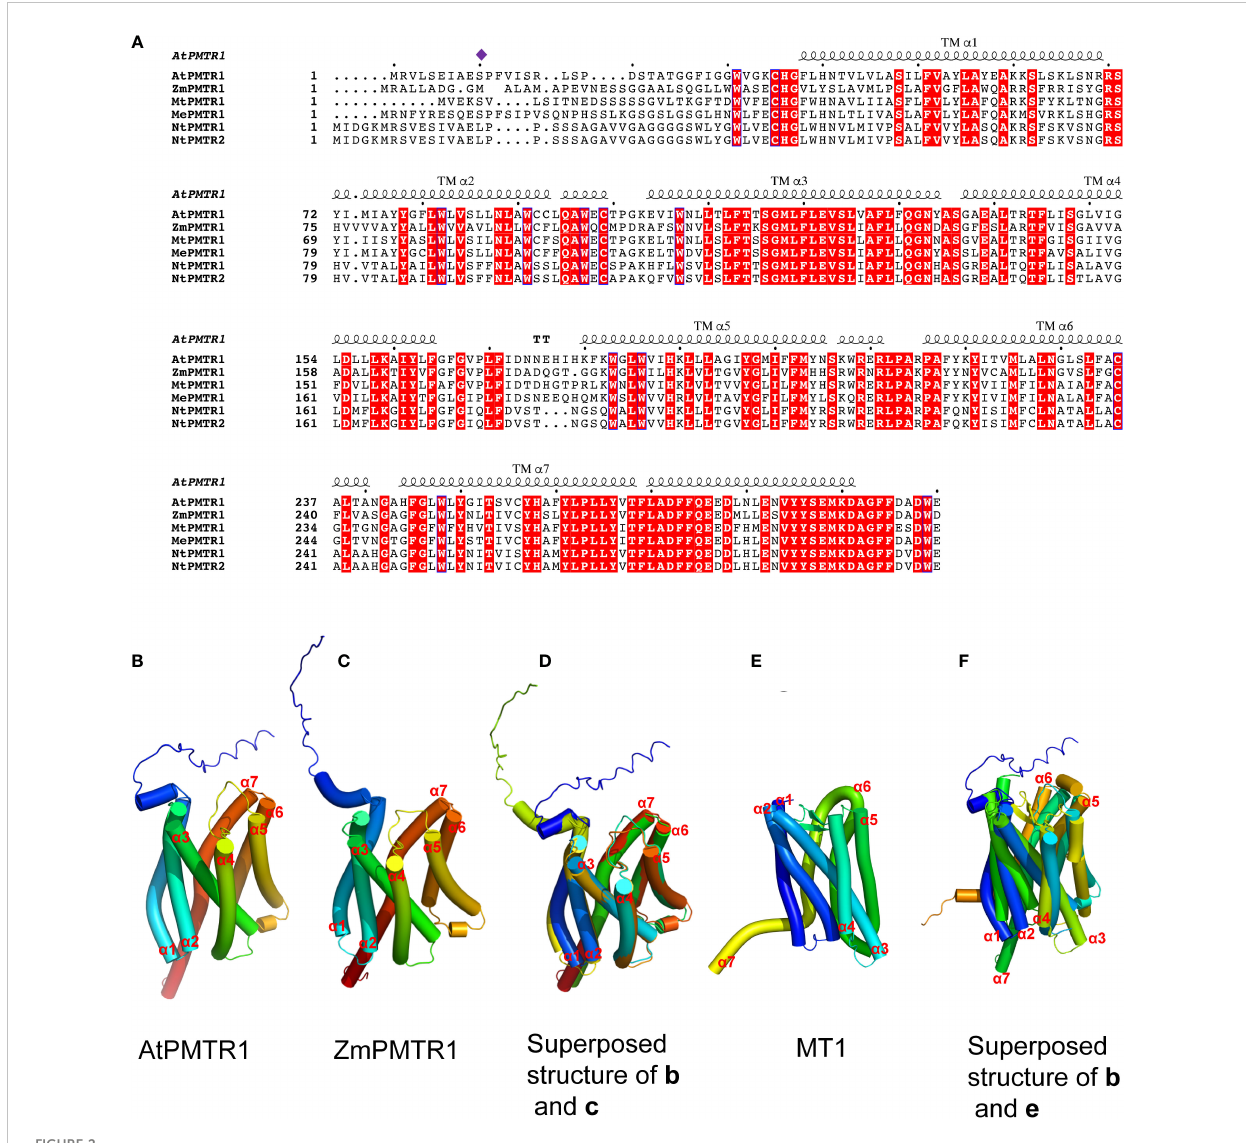
FIGURE 2 Multiple sequence alignment and structural modeling of AtPMTR1 and its homologs from Medicago sativa L. (MtPMTR1: XP_039685271.1), Nicotiana benthamiana (NtPMTR1: XP_019237084.1, NtPMTR2: XP_016433779.1), Zea mays (ZmPMTR1:NP_001136530.1), and cassava (MePMTR1: XP_021623418.1). (A) Multiple sequence alignment of AtPMTR1 and its homologs. Residues responsible for the binding of phytomelatonin are indicated by purple diamonds . Seven-transmembrane a -helices (TM a 1 – 7) are marked on the sequence. (B – F) Structural modeling of PMTR1 from A thaliana